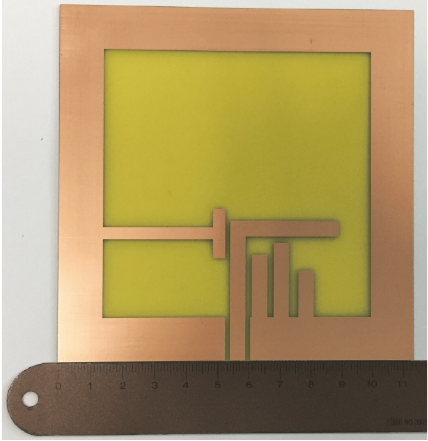
Figure 2: Photograph of the fabricated antenna.